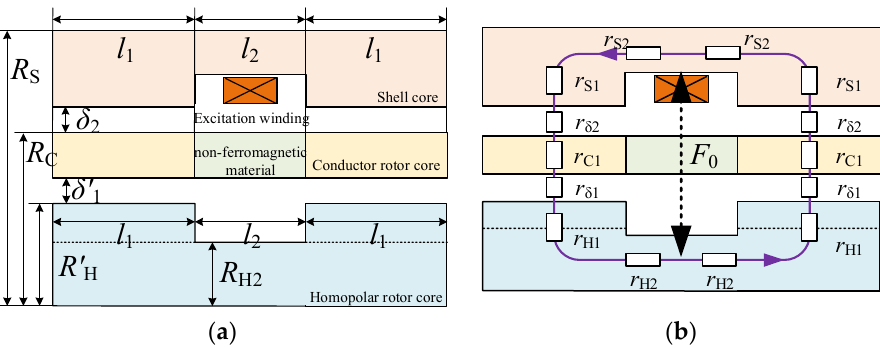
Figure 11. The key parameters and magnetic equivalent circuit of the HTR-ASD. ( a ) The key parameters of the machine. ( b ) The MEC of the calculation.